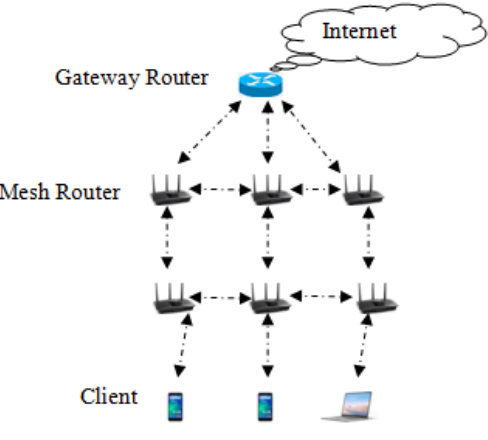
Figure 1. Architecture of